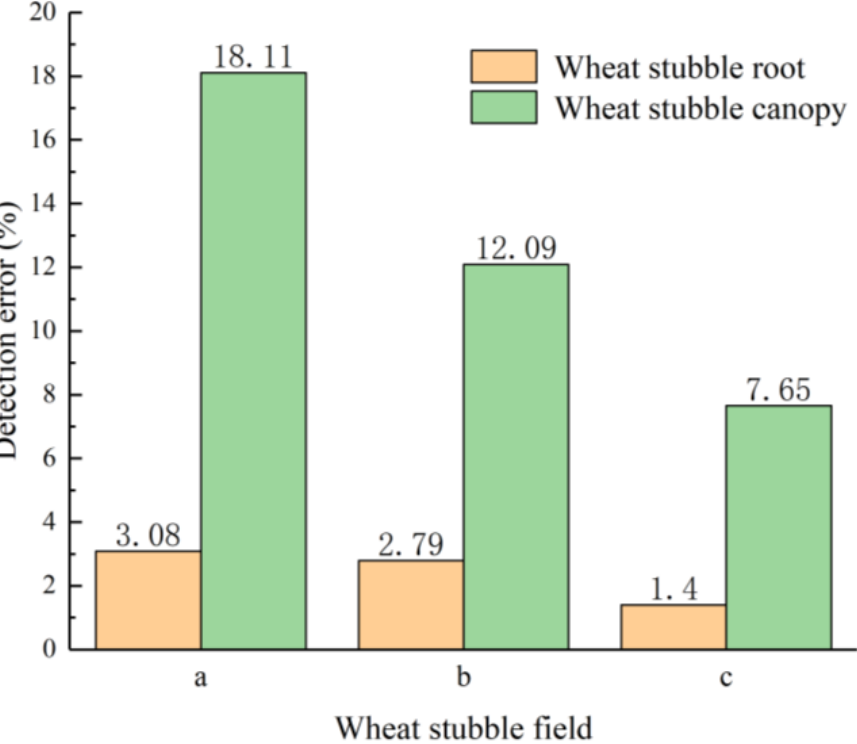
Figure 12. Mean errors of the LiDAR sensor for the WS roots and canopy in each of areas a, b, and c. To investigate the effects of V LiDAR on the detection performance of the LiDAR sensor for the WS roots and canopy in each area, the detection errors of the LiDAR sensor moving at different speeds for the WS roots and canopy in each area were analysed. Table 3 summarizes the results. As demonstrated in Table 3, V LiDAR has a greater impact on the detection performance of the LiDAR sensor for the WS canopy than that for the WS roots in each area. For the WS roots in areas a, b, and c, the maximum detection errors of the LiDAR sensors are 4.66%, 3.67%, and 2.44%, respectively, and the minimum detection errors are 2.43%, 2.45%, and 0.68%, respectively. For the WS canopies in areas a, b, and c, the maximum detection errors of the LiDAR sensors are 20.02%, 12.84%, and 8.50%, respectively, and the minimum detection errors are 16.80%, 11.48%, and 6.65%, respectively. When H WS remains unchanged, V LiDAR has a slight impact on the detection errors of the LiDAR sensor for the WS roots and canopy. In addition, when V LiDAR remains unchanged, as the WS canopy height decreases, the detection errors of the LiDAR sensor for the WS roots and canopy